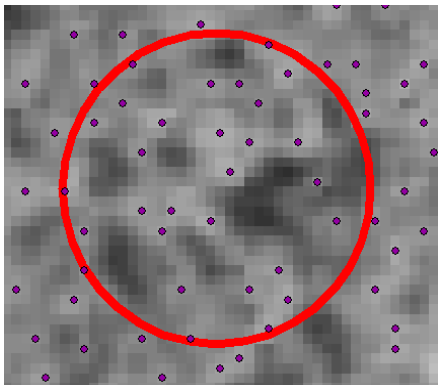
Figure 5. Local maxima detected from the implementation of the automatic procedure on the red band, superimposed on the same band (plot ID 8, Calabrian pine).